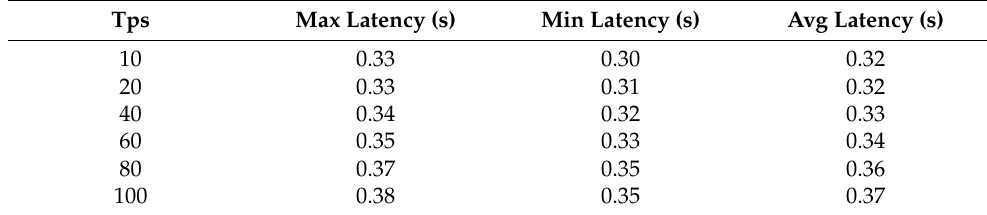
Table 2. Latency of readOnchainData with consensus